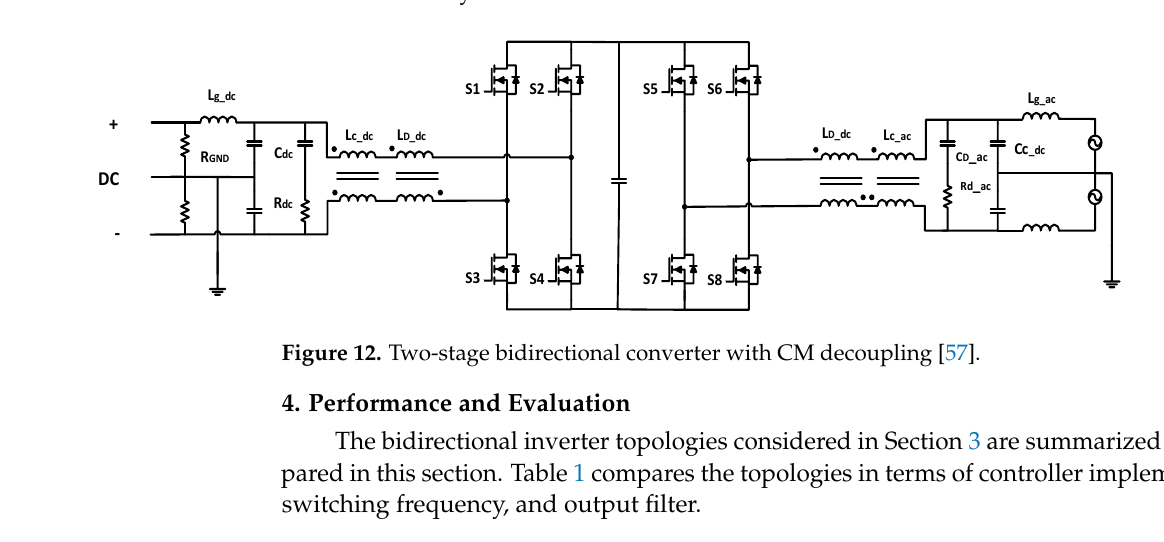
( b ) Figure 11. H6 bidirectional inverter topology: ( a ) standard H6 [53] and ( b ) synchronous H6 [54]. A small number of papers discuss bidirectional inverters for a bipolar DC configura- tion, in which the DC and low-frequency CM voltages need to be closely regulated to ensure symmetrical DC bus voltages and to reduce leakage current. The high-frequency CM noise can be filtered out by passive components, as with unipolar DC systems [23]. The authors of [76] proposed a control solution for grounded unidirectional inverter sys-